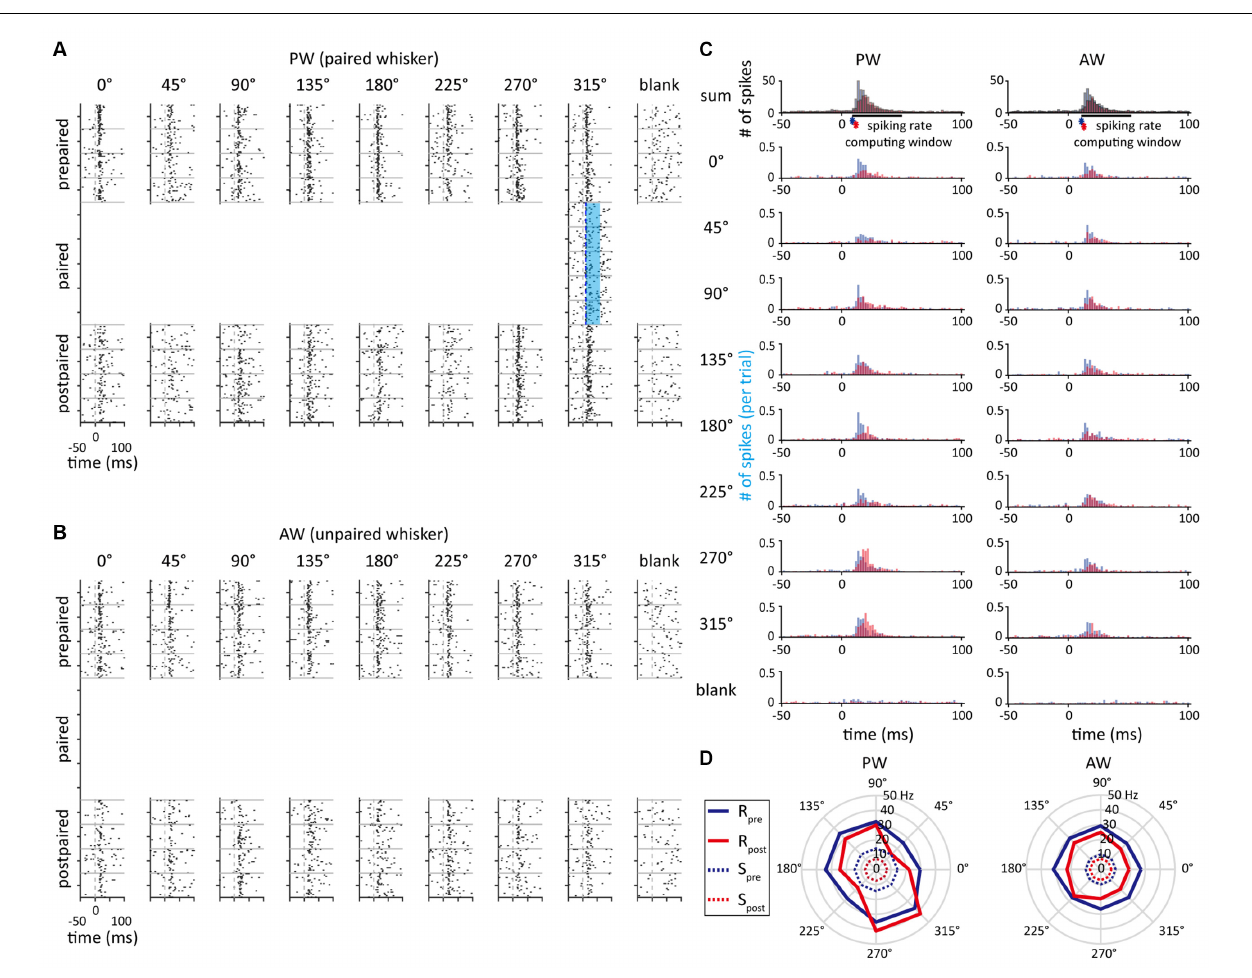
FIGURE 3 | The example unit that showed an increased spiking rate in the paired direction. (A) Peri-event raster plots obtained from the single unit delineated in Figure 2A as a response to whisker stimulation in PW in the prepaired, paired, and postpaired periods. The blue area indicates the time period of optogenetic stimulation. (B) The unit’s peri-event raster plots as a response to whisker stimulation in AW. (C) Peri-stimulus time histograms (PSTHs) obtained from PW and AW stimulations. The asterisks represent the response onset. The blue and red histograms indicate neural responses before and after paired stimulations, respectively. (D) The polar plots represent the neural responses before (blue) and after (red) paired stimulations. Solid and dashed lines indicate spiking rates of stimulus-driven response (R) and spontaneous activity (S),